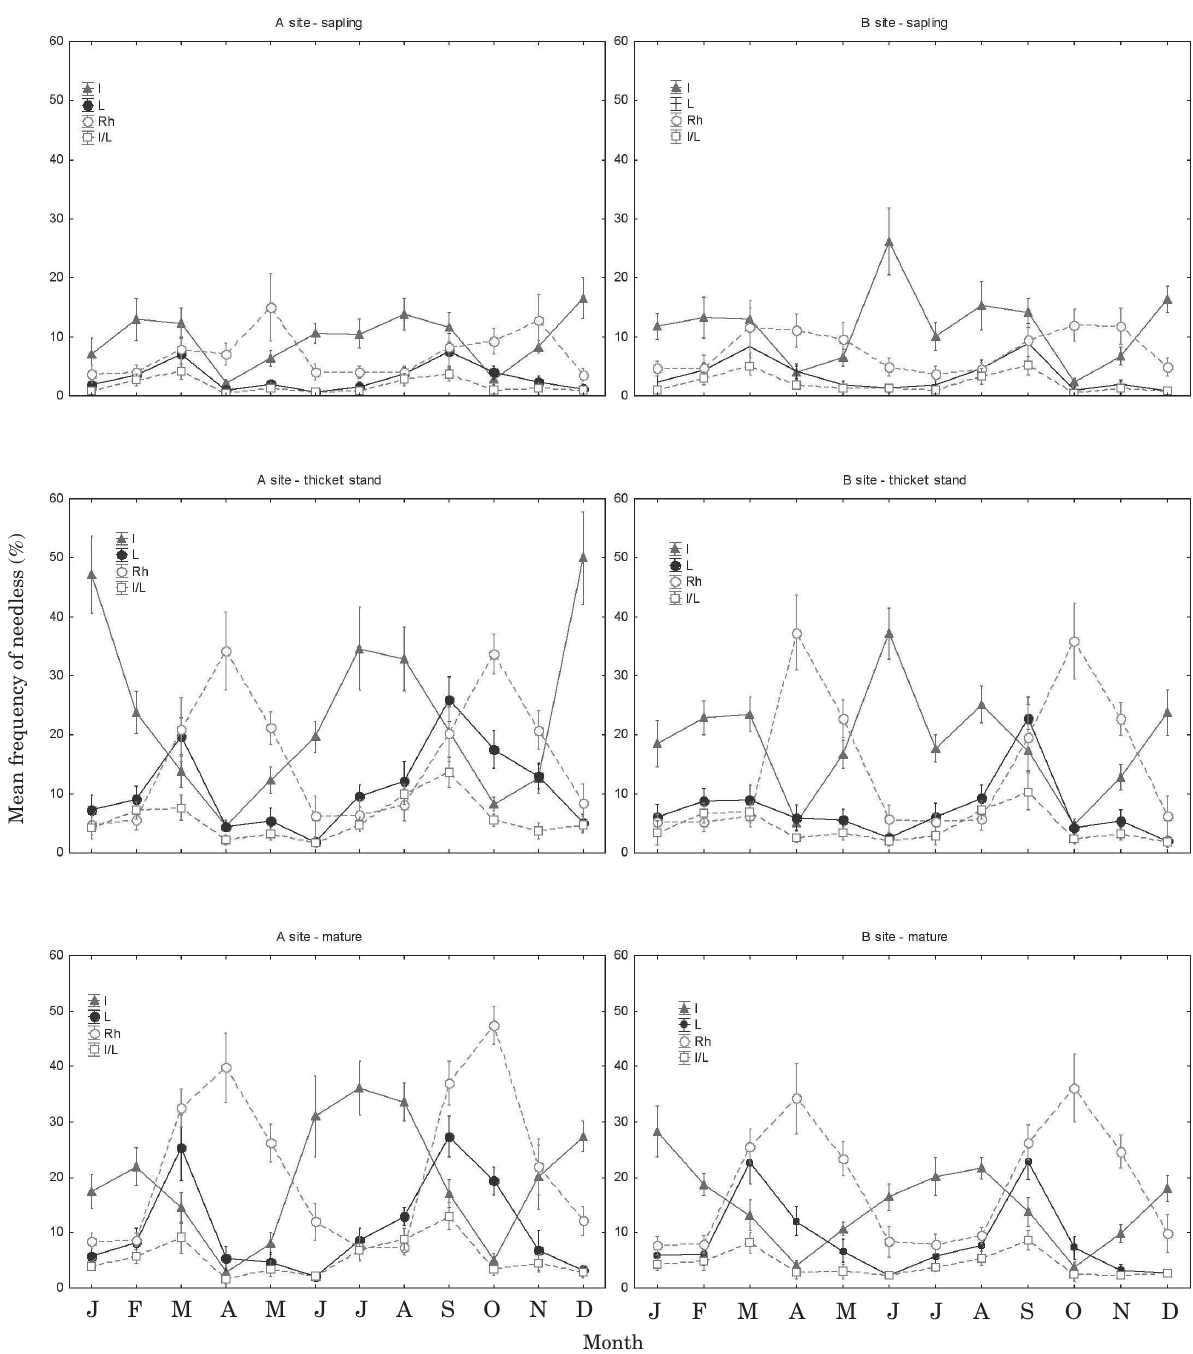
Fig. 3a. Frequency of needles infected with Lophodermium piceae (checked as: conidiomatal stage “l”, ascomatal stage “L”) and Rhizosphaera kalkhoffii (Rh) at sites A and B. Fungal trends are the means of 10 trees in each plot, calculated every two months. The simultaneous occurrence of the conidiomatal and the ascomatal stage of L. piceae is represented by the “l/L” line. The data point values of a month, with standard errors ( P <0.05) indicated by whiskers, relate to that and the